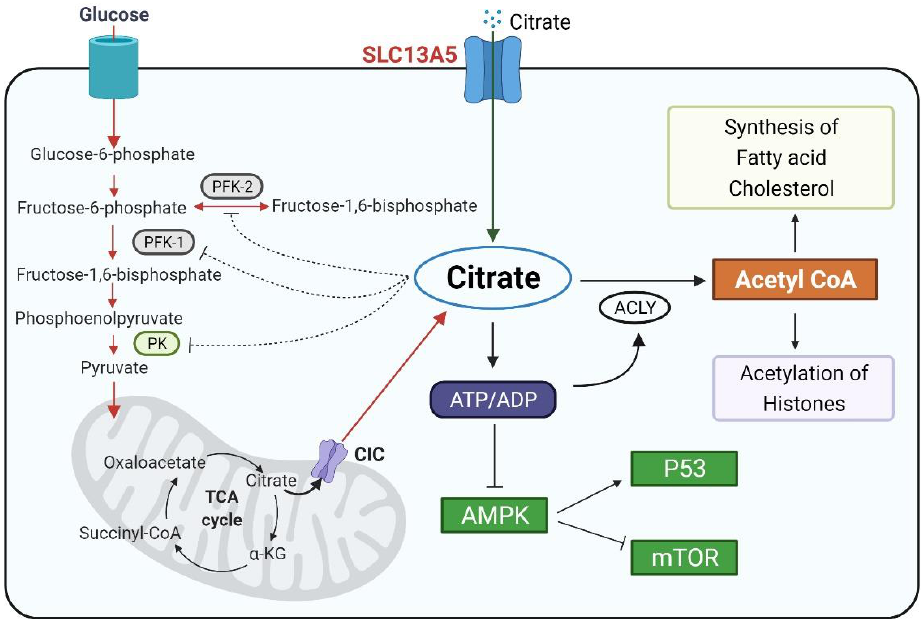
Figure 1. Schematic illustration of the cytosolic citrate balance and function. Citrate is synthesized in the mitochondria through the TCA cycle and transported to the cytosol via CIC (SLC25A1). Another source of cytosolic citrate is from extracellular spaces imported by SLC13A5/NaCT. Functionally, cytosolic citrate can (1) serve as a precursor for acetyl-CoA and play a key role in lipogenesis and histone acetylation; (2) suppress the glycolysis pathway via the inhibition of PFK1, PFK2, and PK, and (3) increase the ATP/ADP ratio and repress the AMPK signaling, affecting the cell proliferation. The schematic figures were created using BioRender (biorender.com, accessed on 4 October 2021).